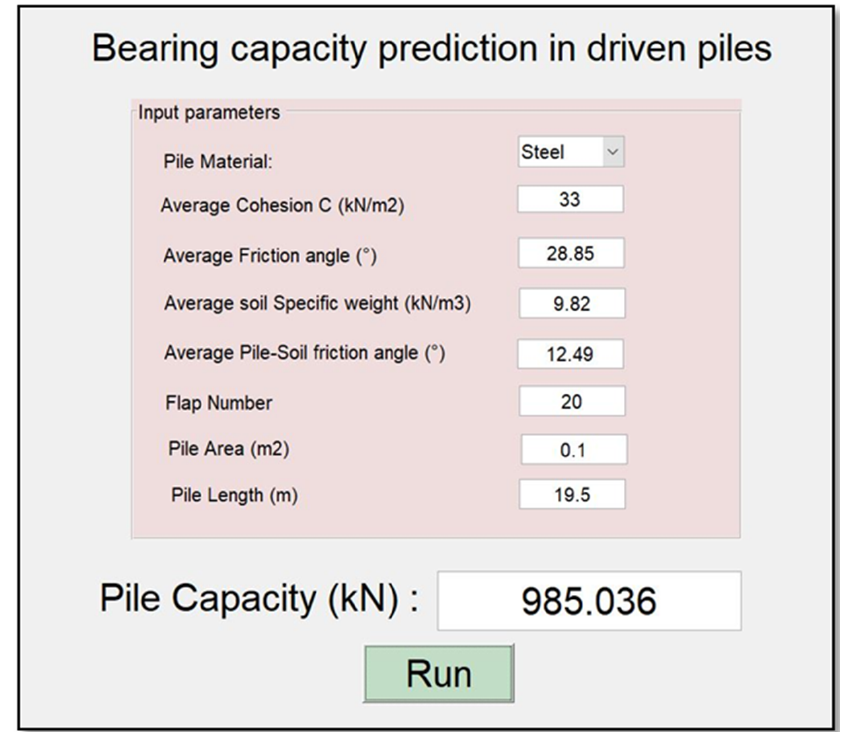
Figure 5. BeaCa2021 interface.